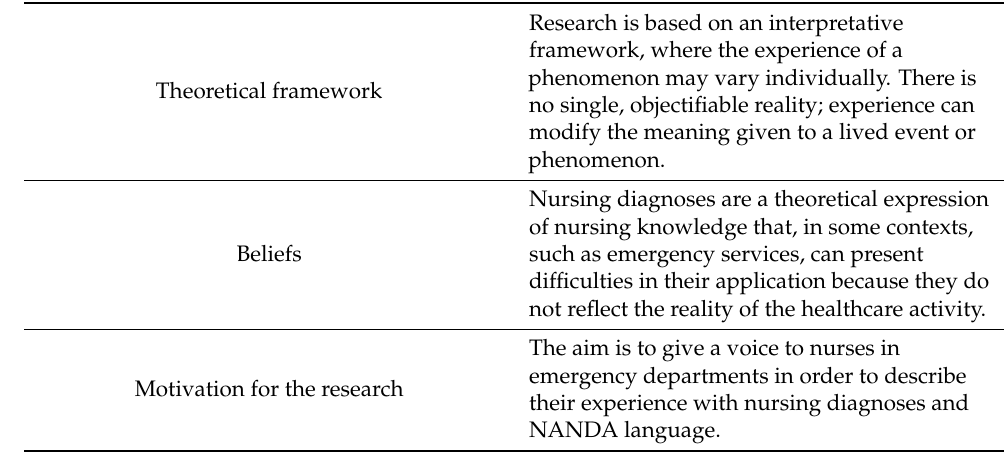
Table 1. The readiness of